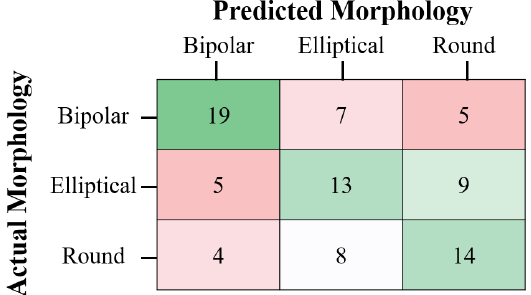
Figure 14. The confusion matrix of PNe morphology using HASH Optical with DenseNet201 DTL model